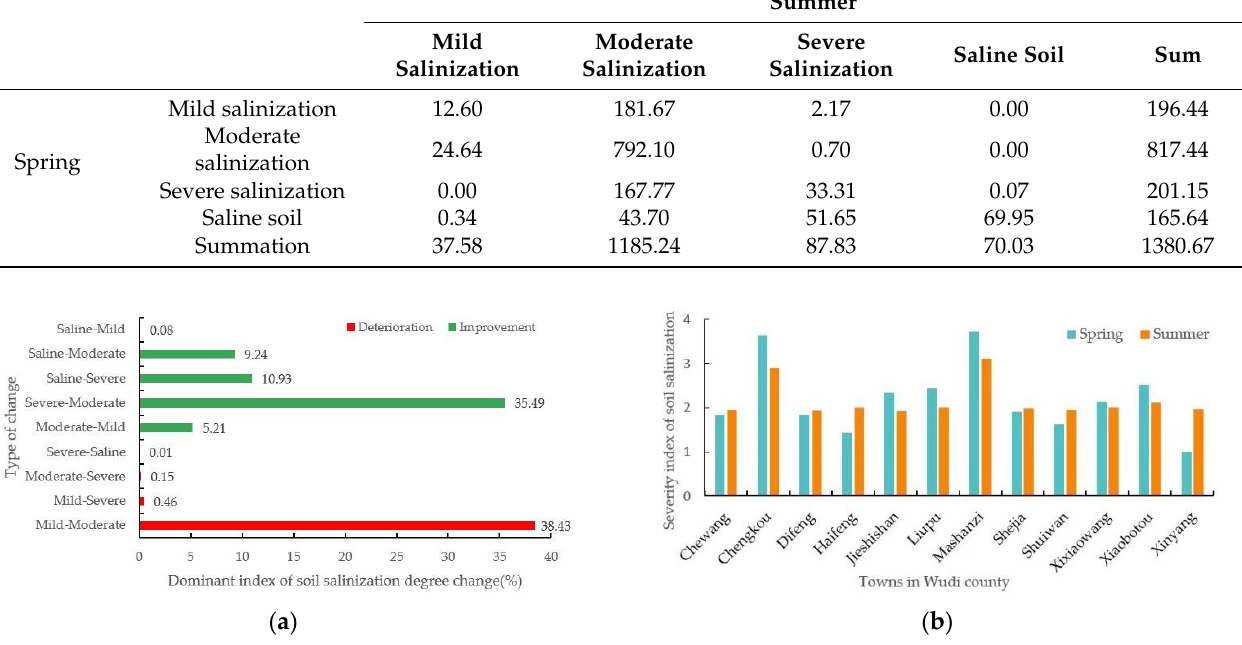
Figure 5. Change degree of soil salinization: ( a ) Dominant index of soil salinization degree change; ( b ) Severity index of soil salinization.